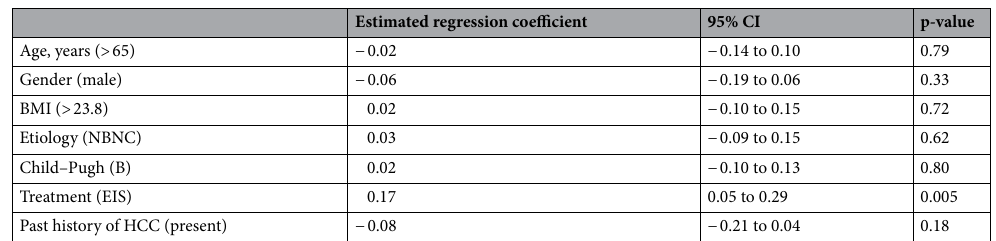
Table 4. Linear regression analysis about factors associated with increasing of serum albumin levels after variceal treatment in all patients. BMI body mass index, CI confidence interval, EIS endoscopic injection sclerotherapy, EVL endoscopic variceal ligation, HBV hepatitis B virus, HCC hepatocellular carcinoma, HCV hepatitis C virus, NBNC non-hepatitis B virus and non-hepatitis C virus.